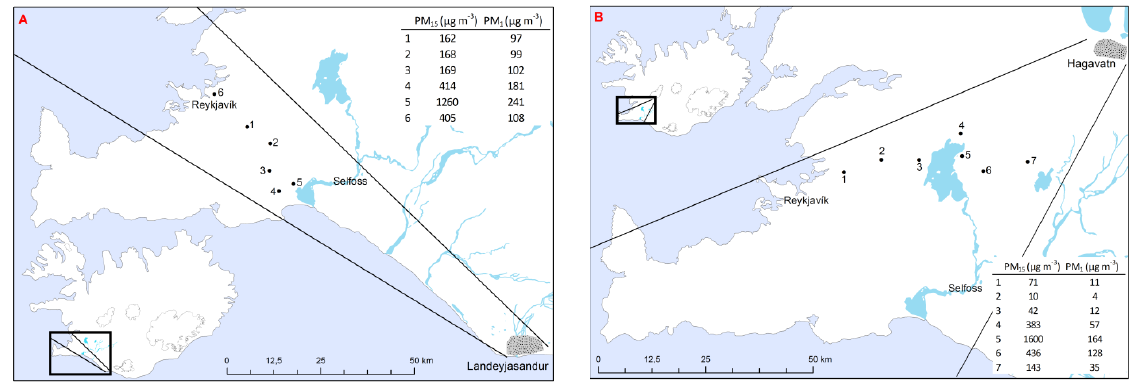
Figure 1. Spatial location of the dust storms. Left figure ( A , Storm 1) shows the dust storm from Landeyjasandur on 15 June 2015. The measurement locations are marked on the map with the numbers corresponding to the information on the PM 15 and PM 1 concentrations in the table. Right figure ( B , Storm 2) shows the dust storm from the Hagavatn on 4 August 2015. The lines on the figures depict the dispersal area of the dust plumes estimated from the images of the Icelandic Road and Coastal Administration web camera network [34].